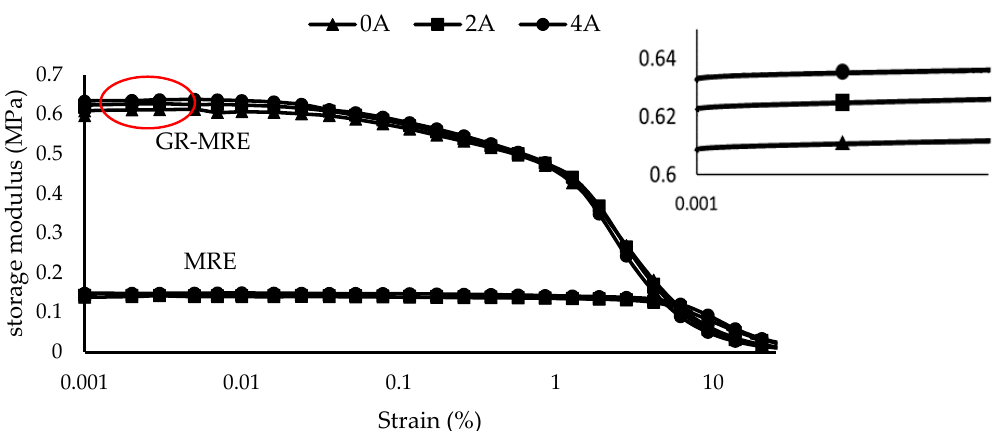
Figure 5. Storage modulus of MRE and Gr-MRE at different strain amplitude at different magnetic fields of 0, 2, and 4 A.